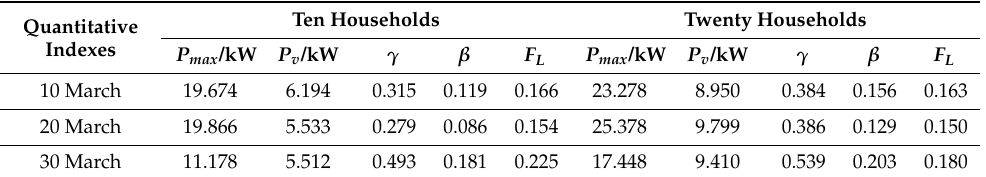
Table 2. Quantitative indicators of the total electric load of the selected multiple